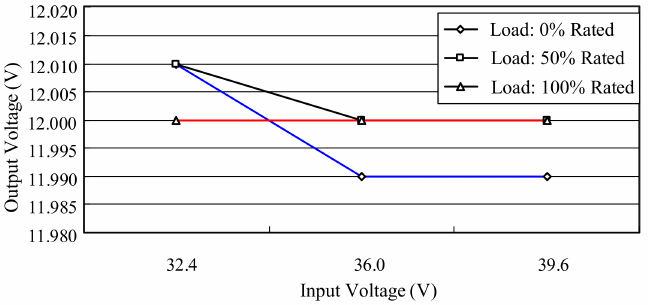
Figure 32. Curve of main output voltage versus input voltage on condition that the first and second secondary outputs are located at rated load.